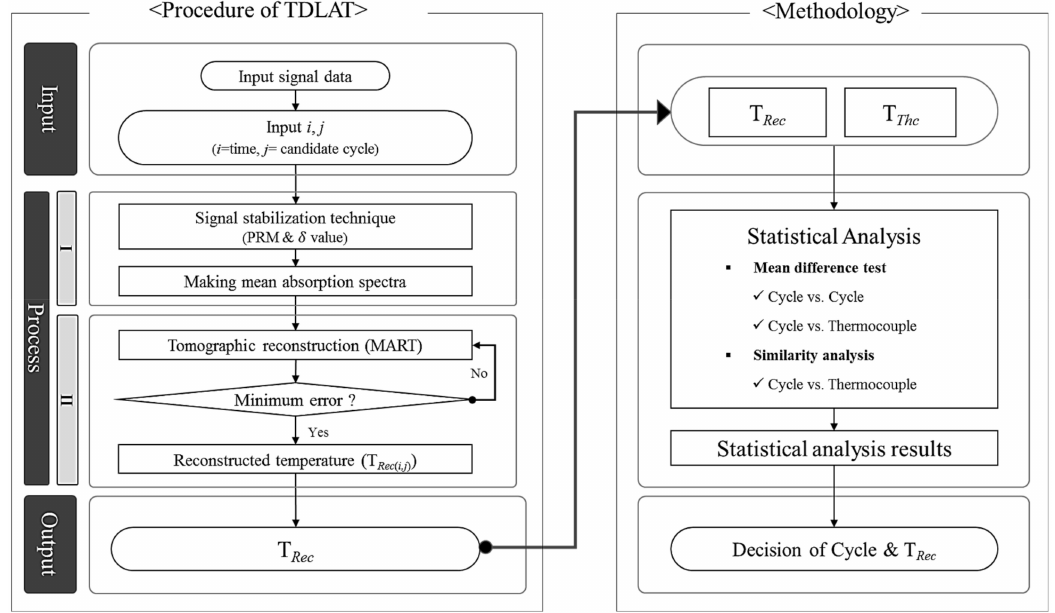
Figure 5. Flowchart for tracking cycle and reconstructed temperature using